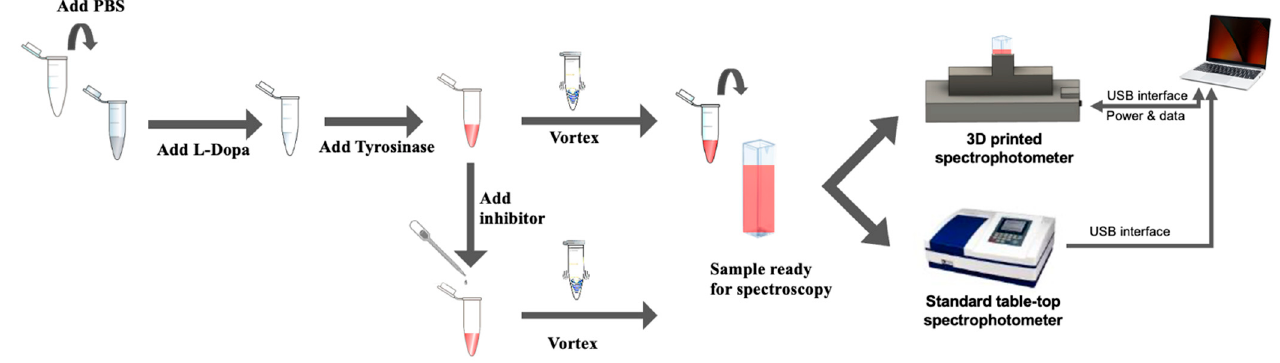
Figure 2. The assay protocol to monitor enzyme